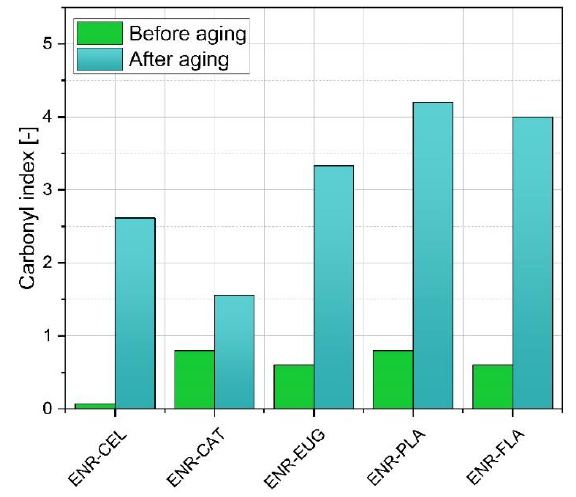
Figure 7. Carbonyl index (CI) values obtained for ENR-based composites before and after solar aging, where C=O groups were observed within the 1750 cm −1 range and CH groups at 2900 cm −1 , respectively.